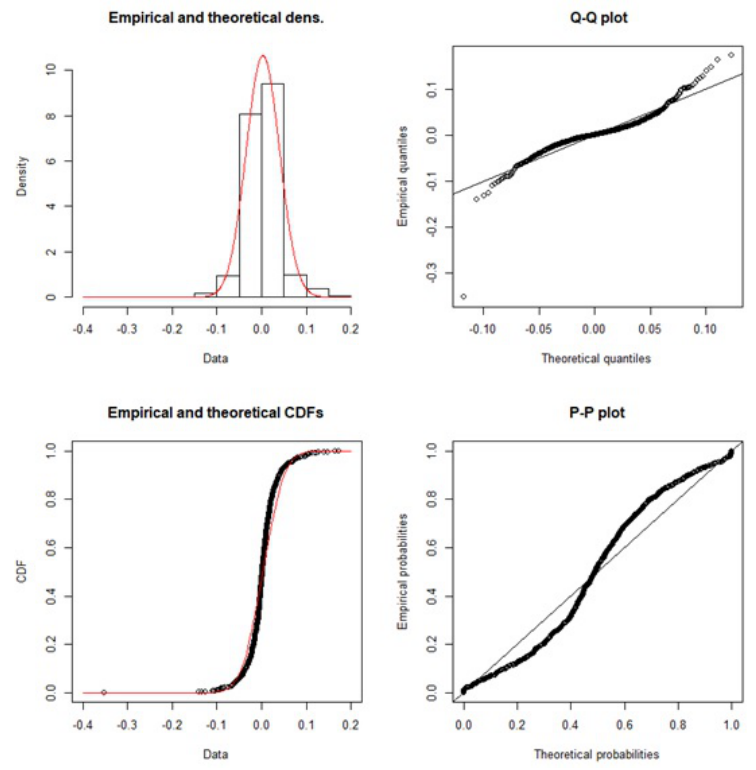
Figure 3. Comparison of Empirical and Theoretical densities.